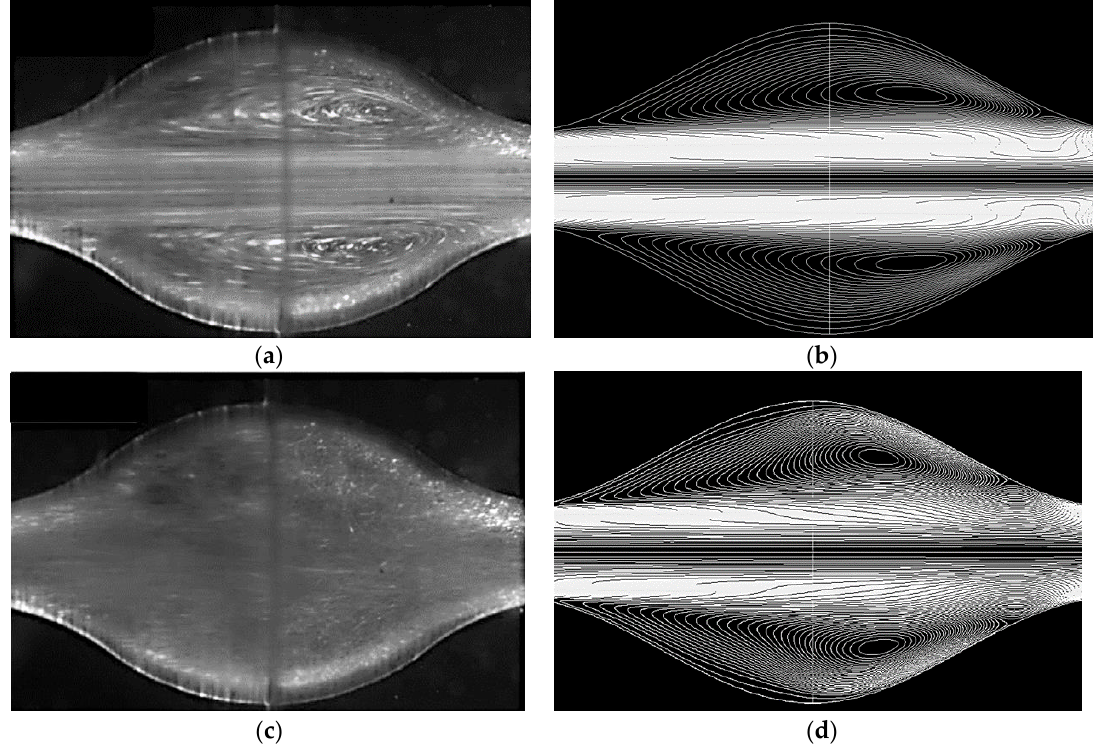
Figure 6. Qualitative comparison of flow inside the wavy-walled tube ( a ) Laminar flow pattern inside wavy-walled tube presented by Yongning Bian et al. [21] ( b ) computed laminar streamlines, ( c ) turbulent flow pattern inside wavy-walled tube presented by Yongning Bian et al. [21], and ( d ) computed turbulent streamlines.